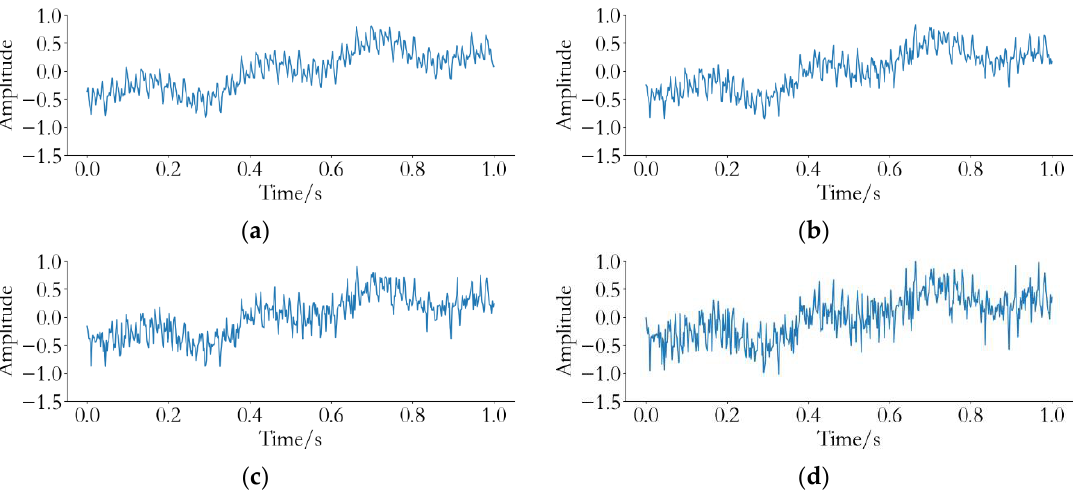
Figure 3. Vibration signals with different signal-to-noise ratios: ( a ) original signal; ( b ) noisy signal (SNR = 15 dB); ( c ) noisy signal (SNR = 10 dB); ( d ) noisy signal (SNR = 5 dB).